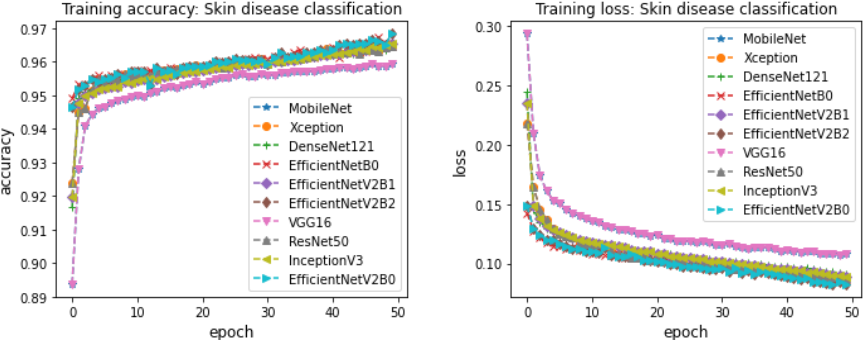
Figure 6. Training accuracy and training loss of CNN-based finetuned models for skin disease classification (left to